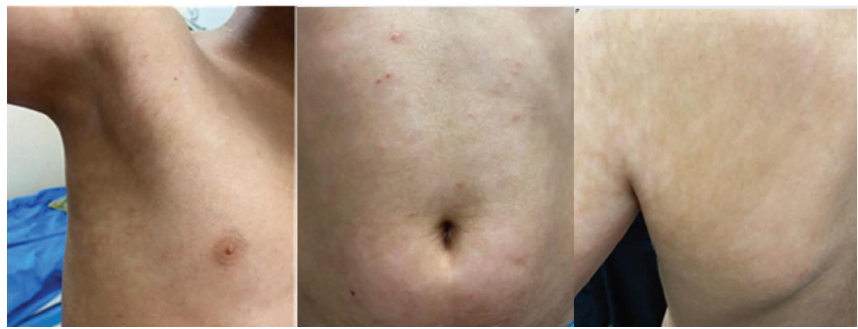
Figure 1: Hypopigmented patches involving the axilla, back, and abdomen.